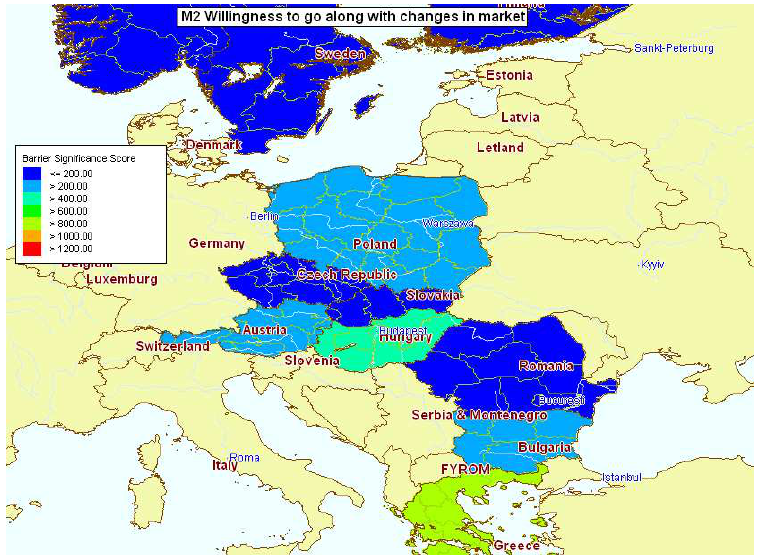
Figure 5. Country-specific BSS for implementation condition M2 (willingness to go along with changes in the market)